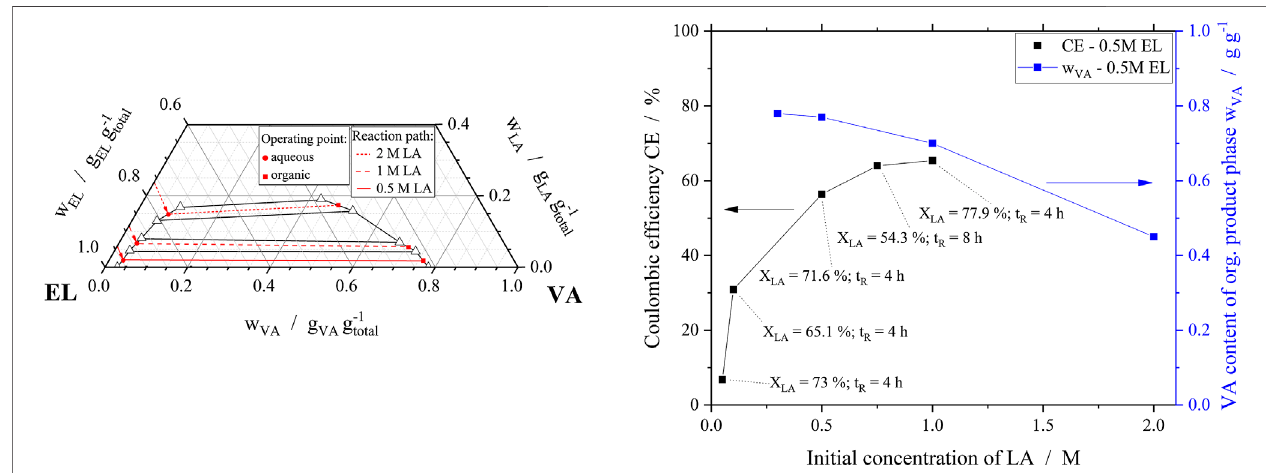
Frontiers in Energy Research |